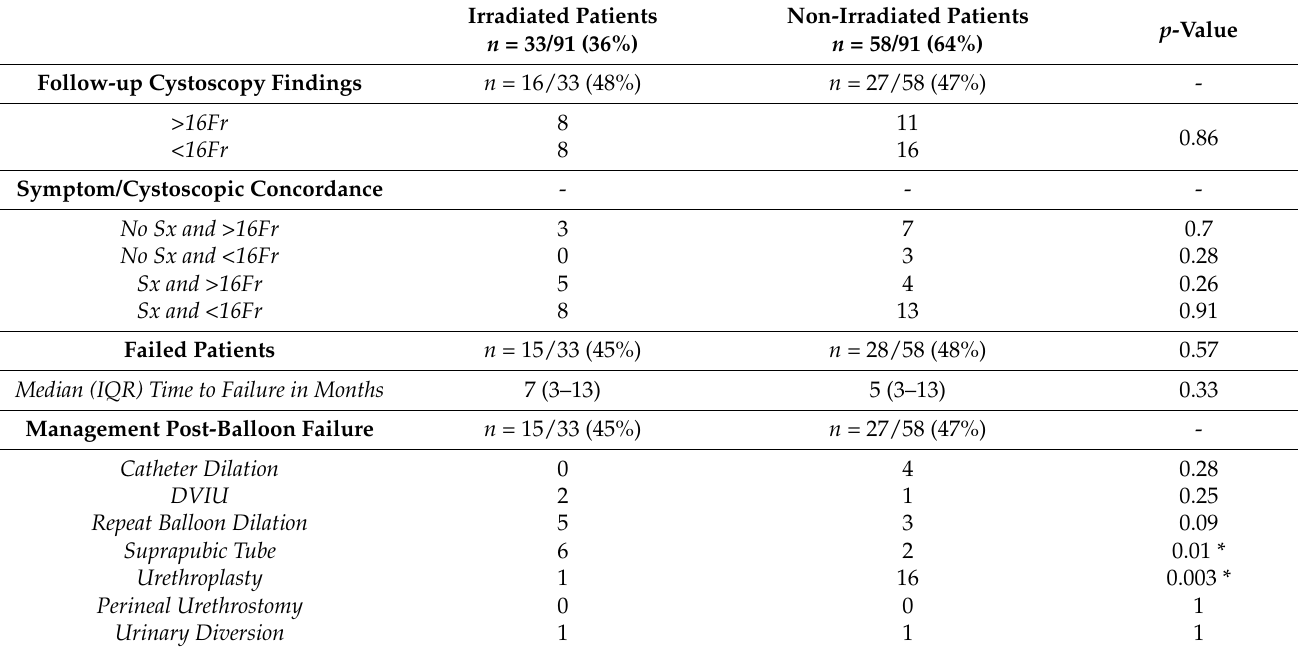
Table 2. Balloon Outcomes in Irradiated vs. Non-Irradiated